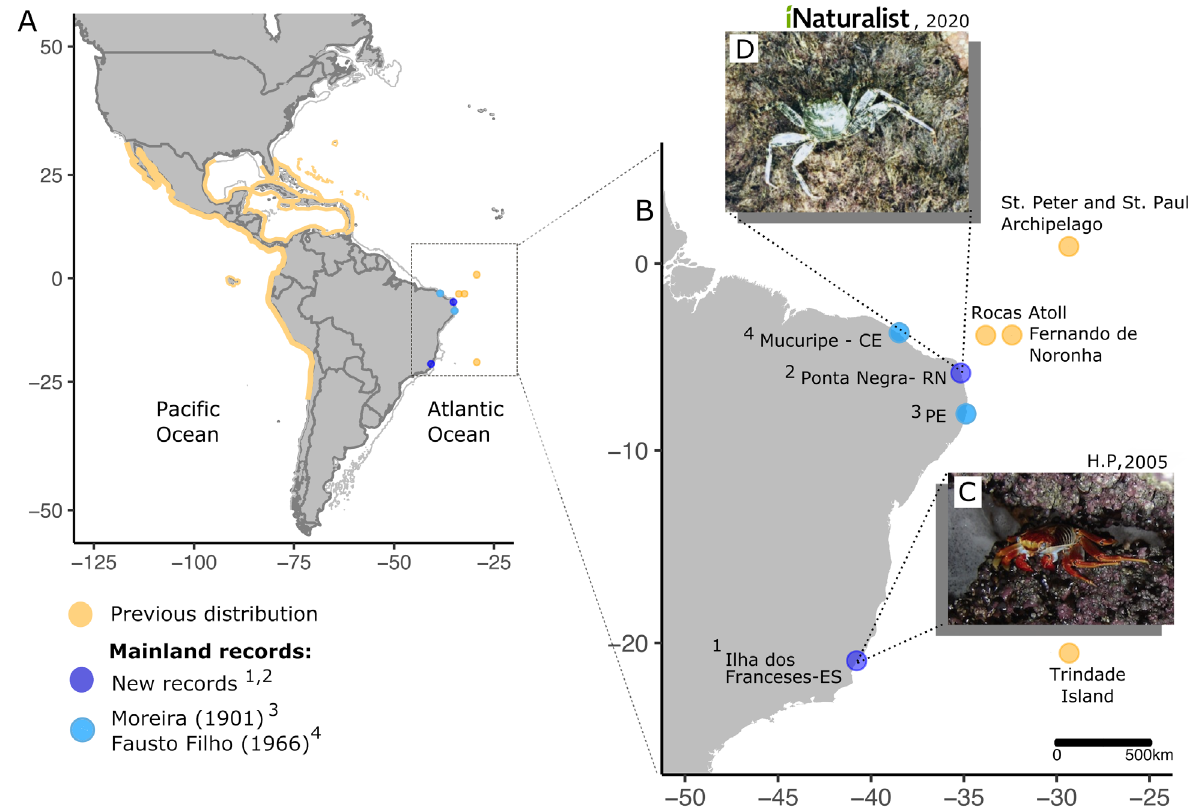
Figure 1. Geographic distribution of Grapsus grapsus . Locations of the mainland records: Fausto Filho (1966), Moreira (1901) ( A ) and new records ( B ). Photographs of the adult individual recorded at Ilha dos Franceses, state of Espírito Santo, Brazil ( C ) and the juvenile individual recorded at Natal, state of Rio Grande do Norte, Brazil ( D ). Images by: Hudson Pinheiro ( C ) and Juliana Lins ( D